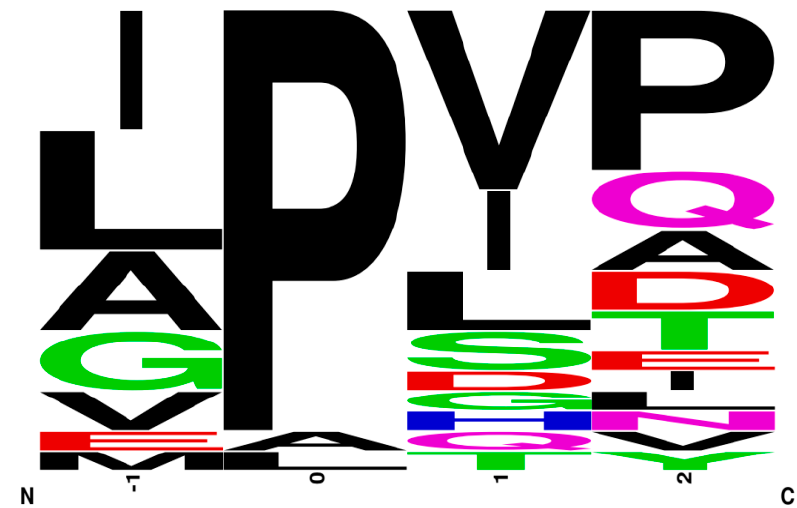
Figure 5. Frequency analysis of amino acid residues contained in highly DPP-IV inhibition peptides (IC 50 < 100 µM) using WebLogo.